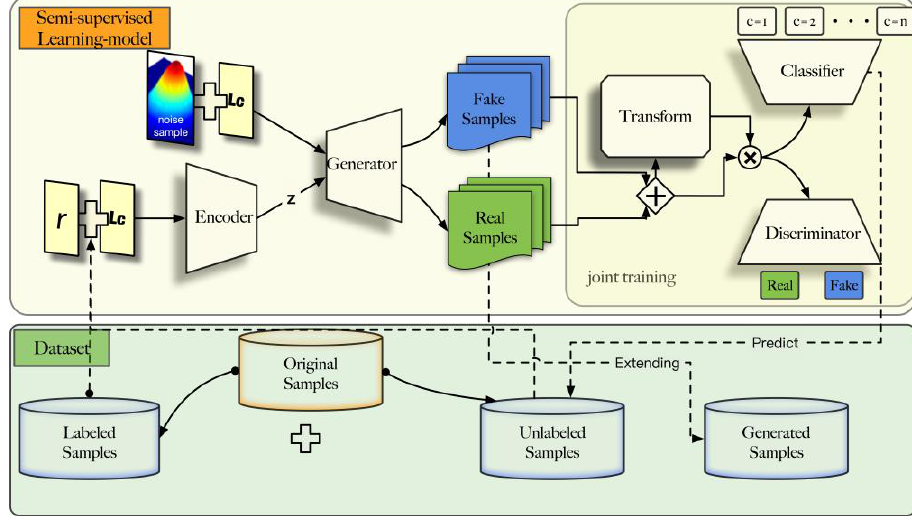
Figure 1. Framework of the generative adversarial networks (GANs)-based semi-supervised learning method.